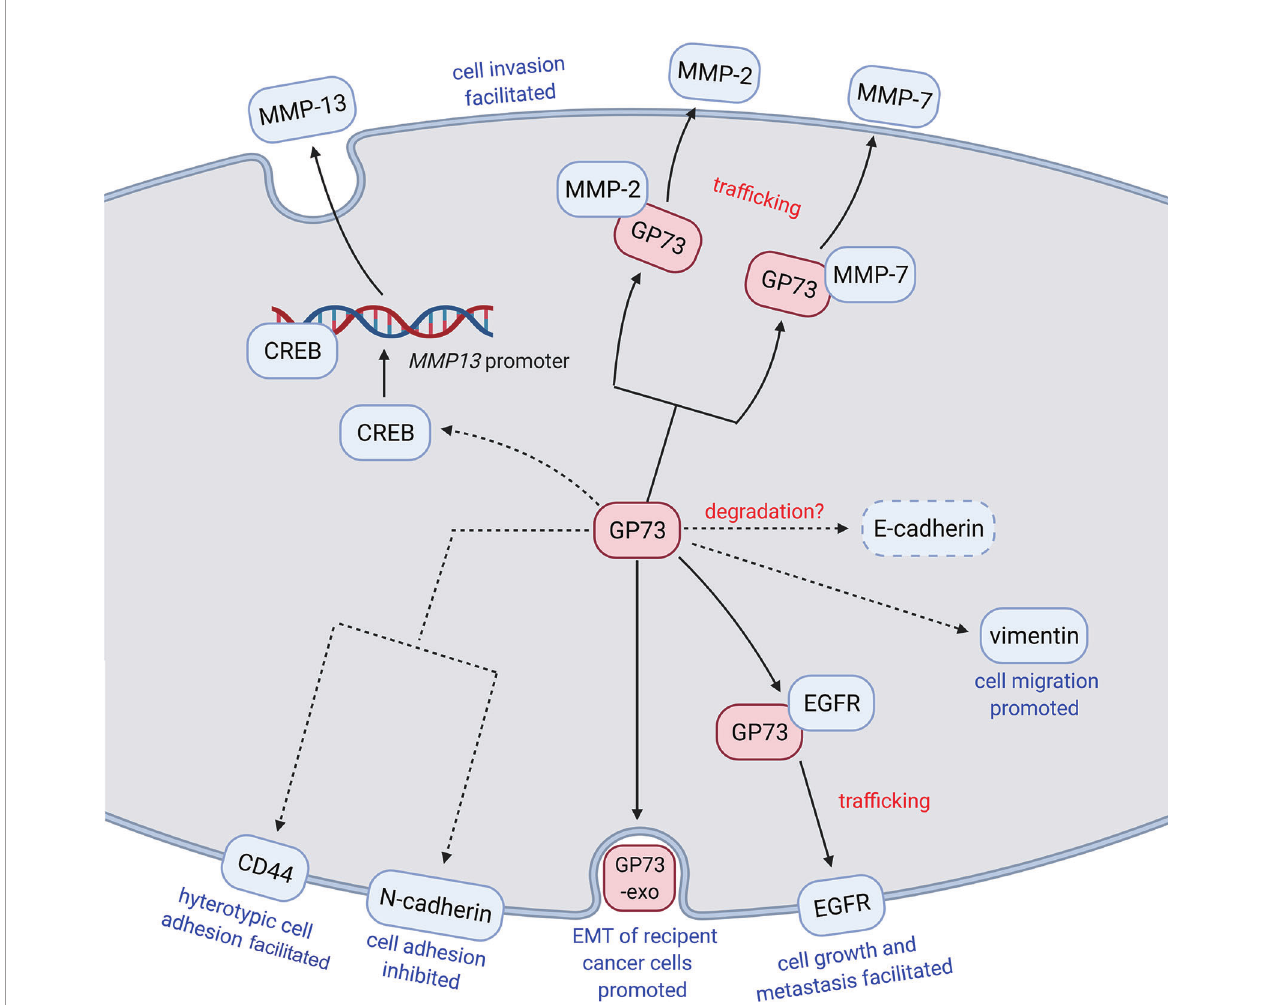
FIGURE 3 | GP73 promotes EMT of cancer cells through different pathways. GP73, as a multifunctional protein, facilitates EMT of cancer cells through regulating the levels, promoting the transactivation, and accelerating the traf fi cking of EMT-related proteins. Exosomal GP73 also plays functional roles in promoting EMT of recipient cancer